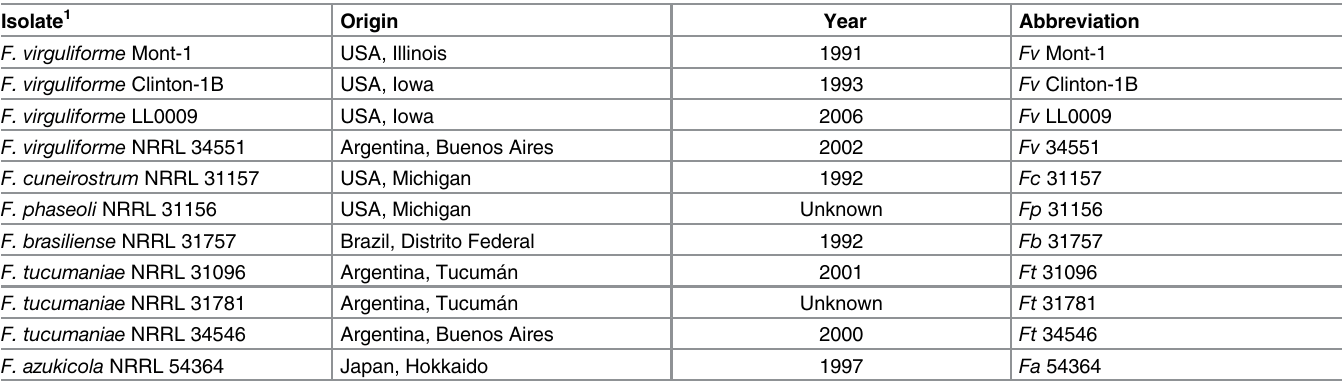
Table 1. Isolates used in this